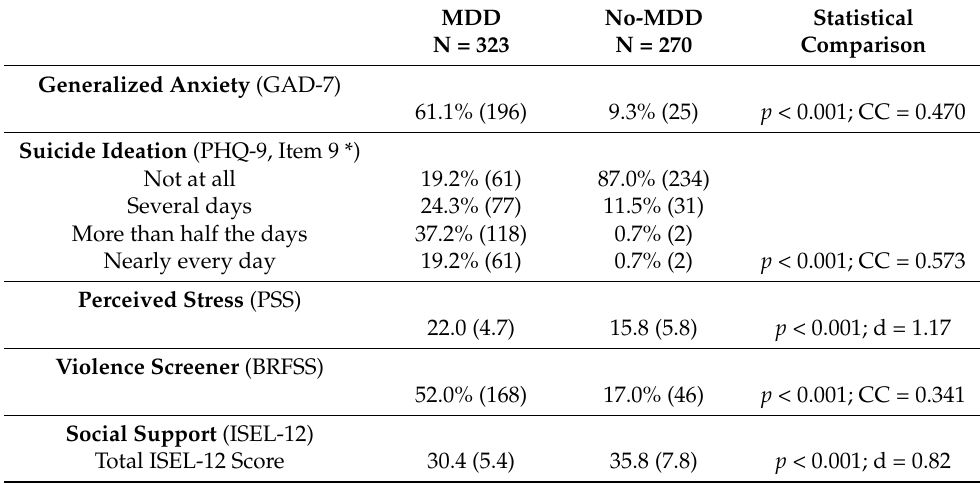
Table 2. Psychosocial Factors Comparisons.